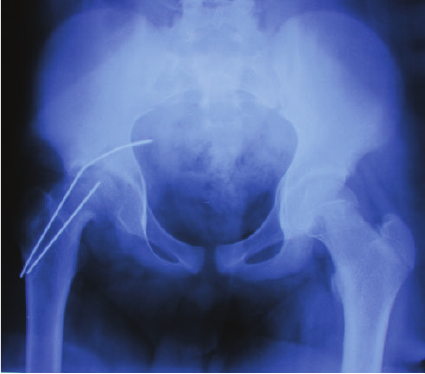
Figure 2: Postoperative radiograph shows intrapelvic migration of K-wire with remaining broken part of K-wire.